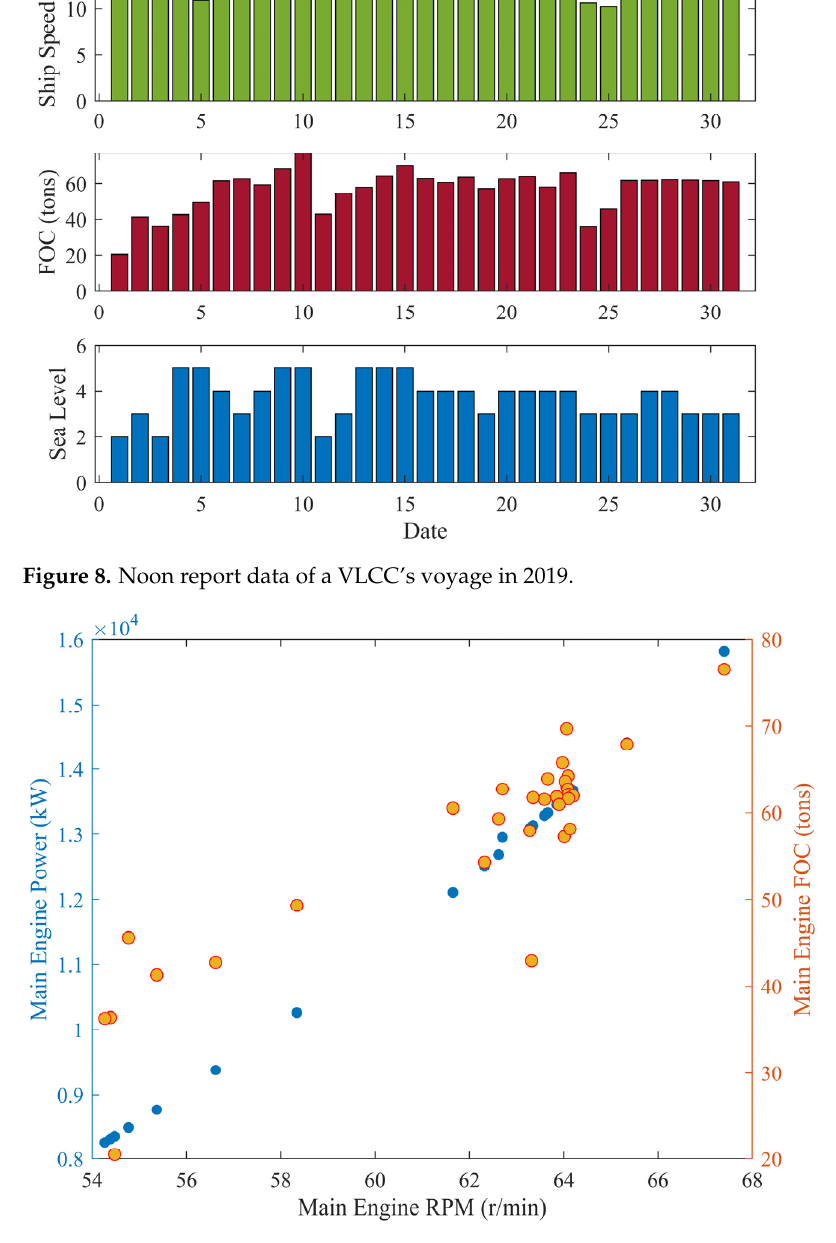
Figure 9. Relationship of main engine rpm with power and FOC.